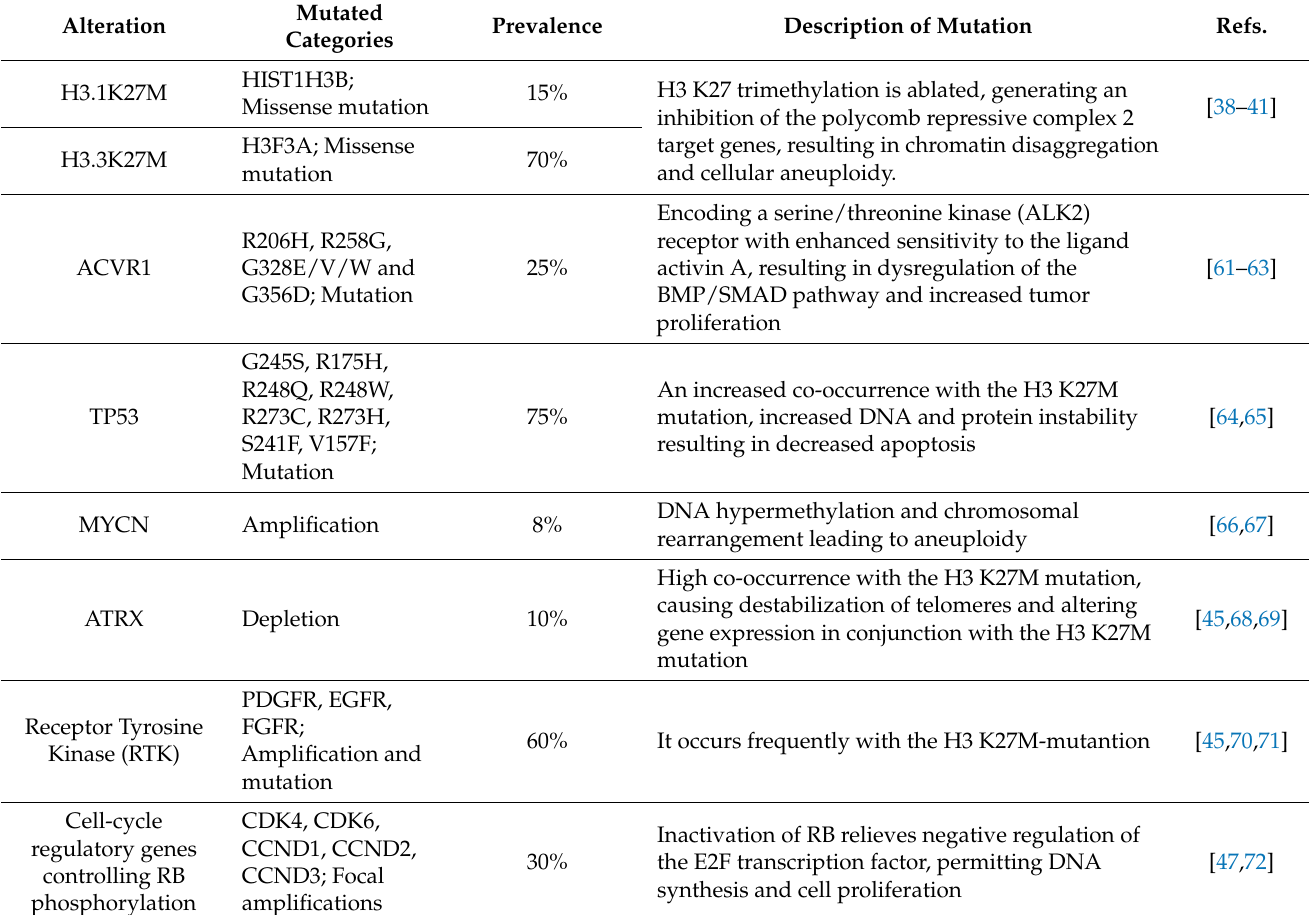
Table 1. Recurring genomic and proteomic alterations in